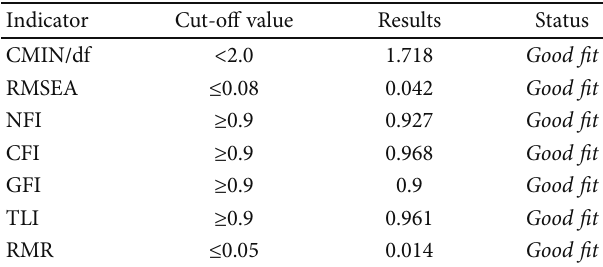
Table 5: GoF test results.